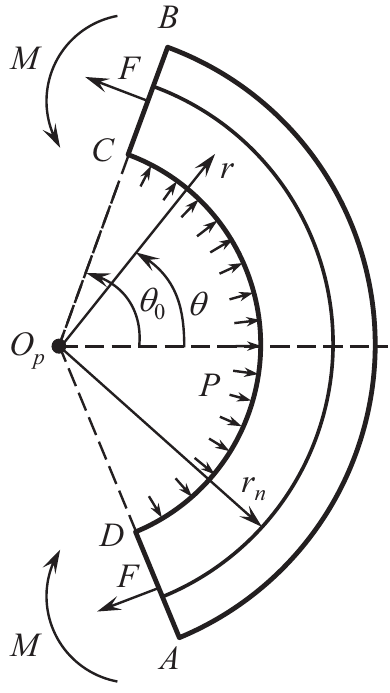
Figure 1. Schematic diagram of the bending